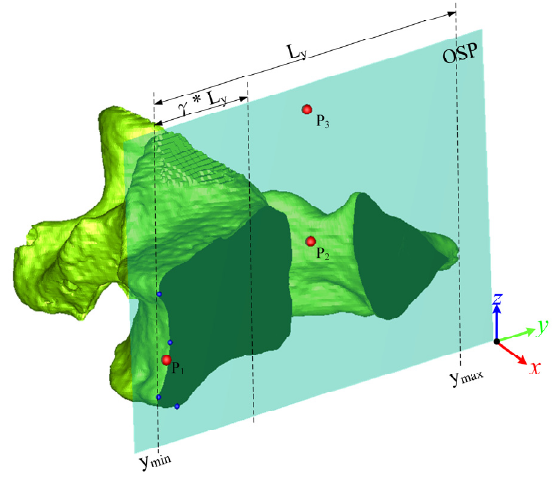
Figure 3. The three vertices on the OSP.